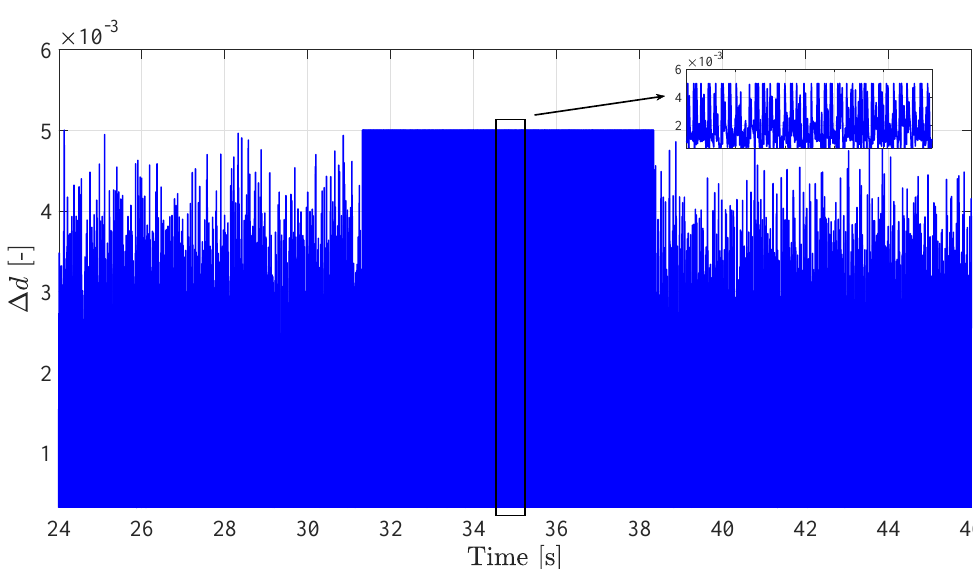
Figure 12. Variation of the duty cycle step-size with the conventional P&O technique.